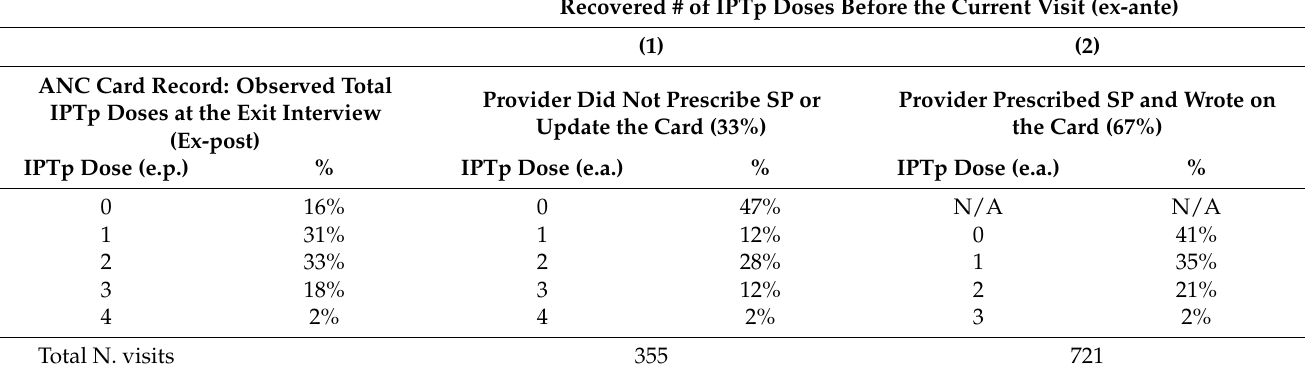
Table A1. IPTp History Recovery.